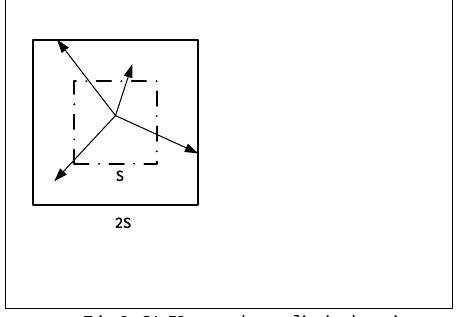
Fig.2. SLIC searches a limited